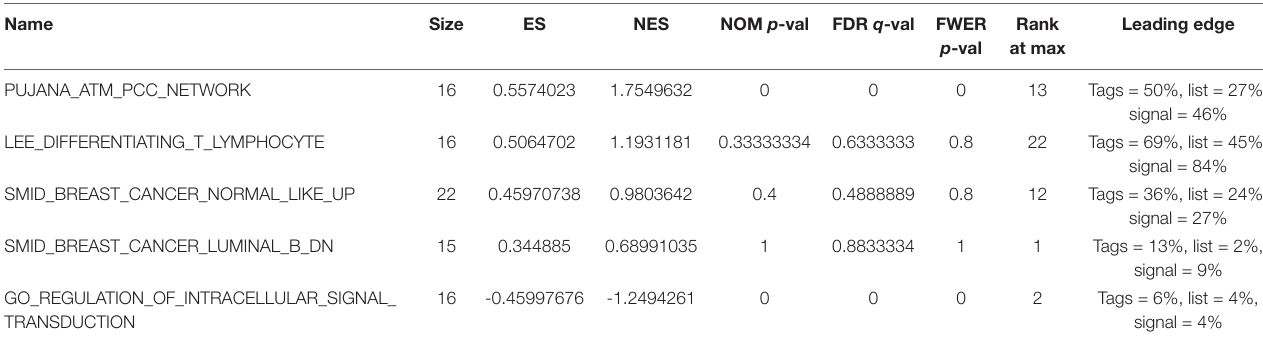
TABLE 3 | The GSEA analysis of 49